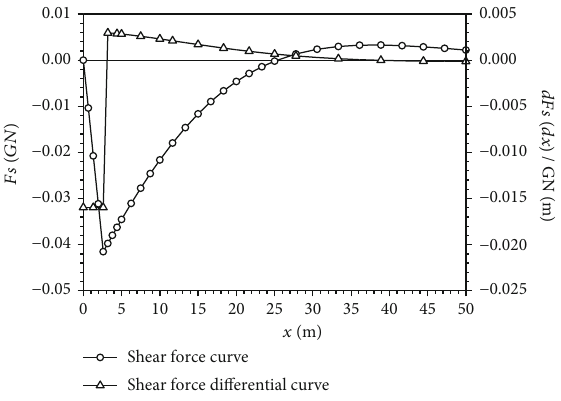
Figure 4: Shear force of composite beam and its di ff erential